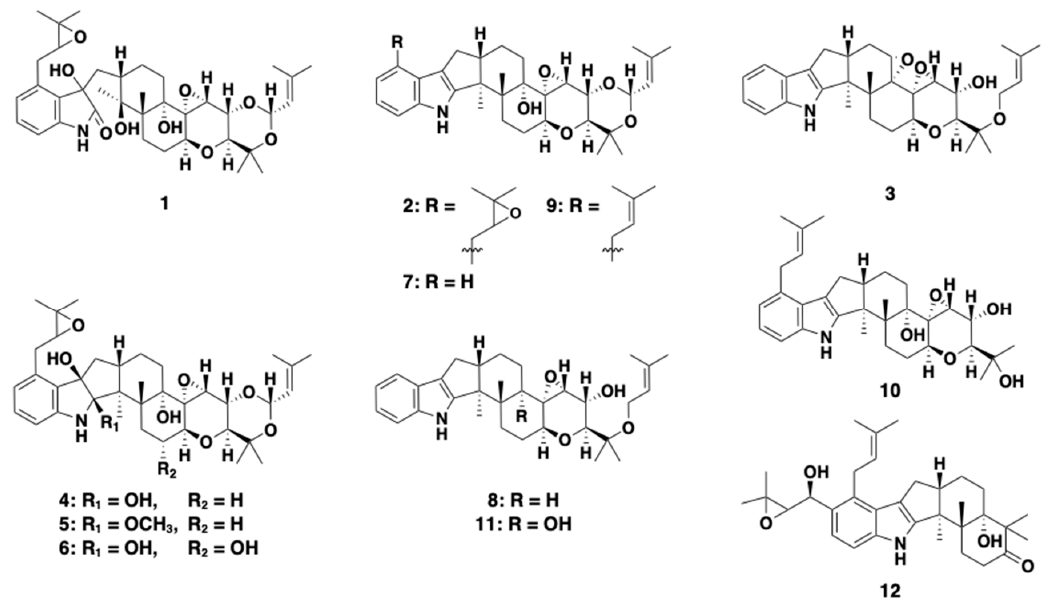
Figure 1. Structures of terpendoles and other known compounds: Terpendole N ( 1 ), terpendole O ( 2 ), terpendole P ( 3 ), voluhemin A ( 4 ), voluhemin B ( 5 ), NK12838 ( 6 ), terpendole C ( 7 ), terpendole D ( 8 ), terpendole L ( 9 ), tolypocladin A ( 10 ), terpendole J ( 11 ), and sespendole ( 12 ).